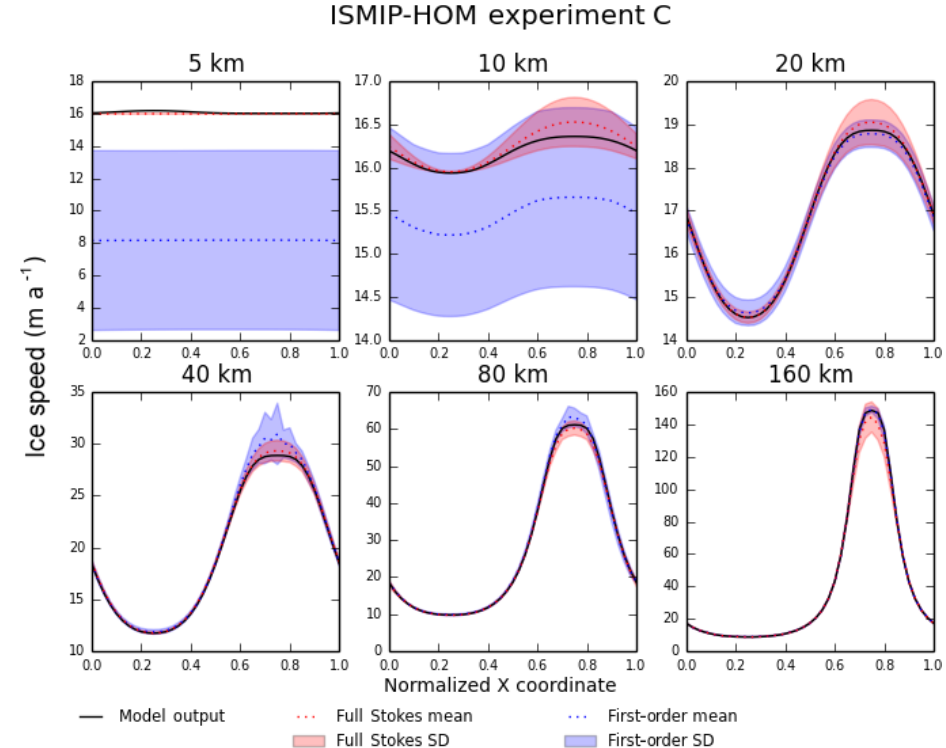
Figure 5. Same as Fig. 4, except that the solid black line shows output from Glissade’s DIVA velocity solver.